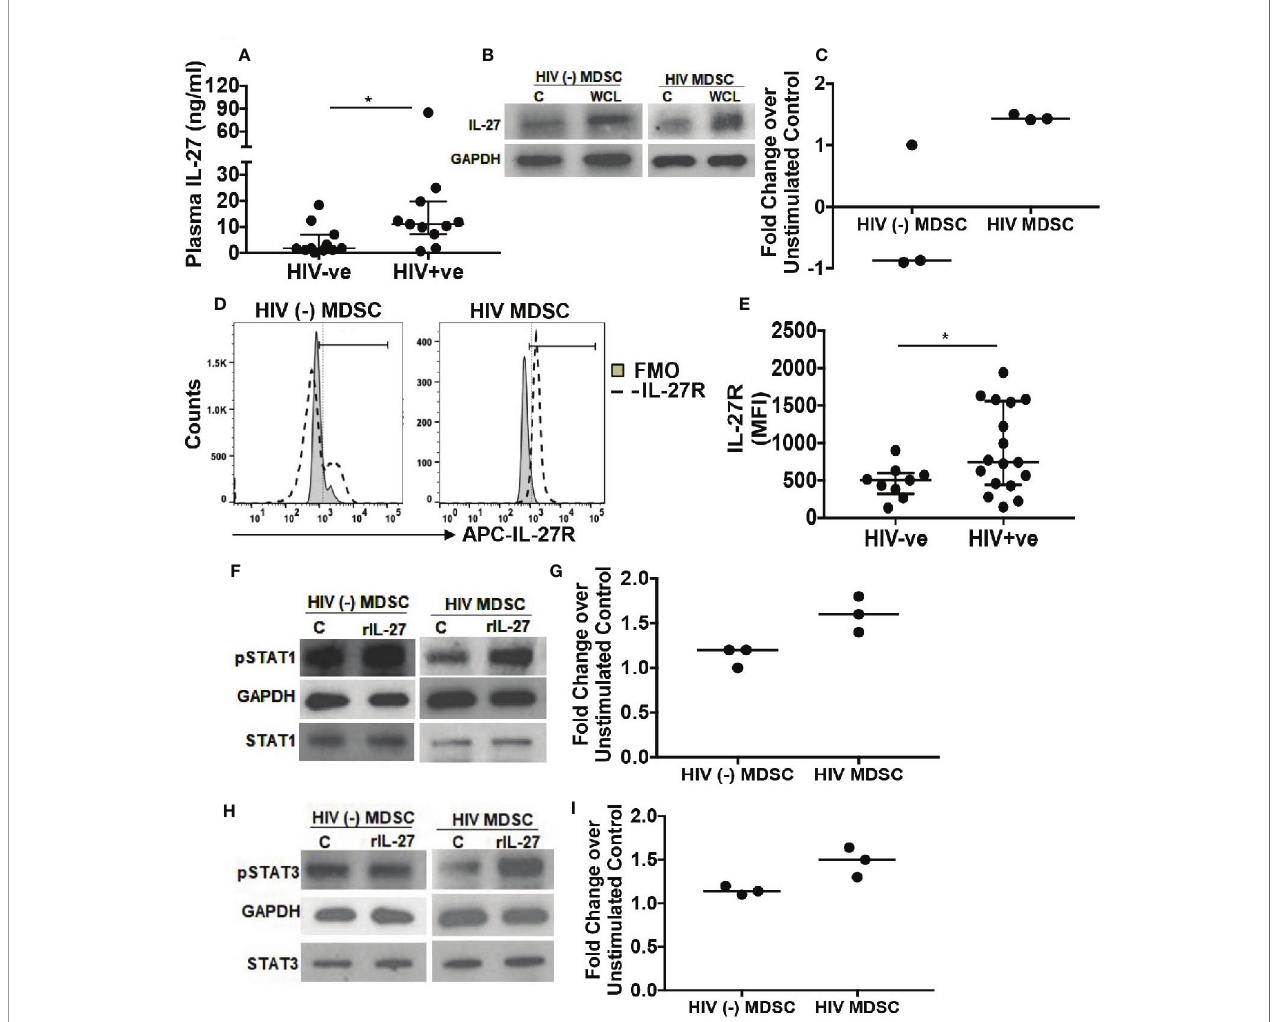
FIGURE 3 | Increased expression of IL-27 and IL-27R by HIV MDSC. To determine the role of IL-27, (A) IL-27 was quantitated in the plasma of HIV (-) and HIV (+) individuals with virologic suppression by ELISA. (B, C) HIV (-) MDSC and HIV MDSC were isolated and cultured without or with M tuberculosis WCL. Total cellular lysates were immunoblotted using anti-GAPDH and – IL-27A antibodies to determine the expression of IL-27p28. Representative Immunoblot of one HIV (-) MDSC and HIV MDSC donor is shown; vertical line is median (B) . (D, E) MDSC were isolated and surface stained with anti-IL-27 receptor (IL-27R) antibody. The expression of IL-27R was determined by fl ow cytometry and Mean Fluorescence Intensity (MFI) calculated. Representative fl ow cytometry plot is shown (D) . (F – I) To determine functional response of IL-27R, MDSC were isolated and stimulated with recombinant IL-27 (rIL-27) for 30-minutes. Total cellular lysates of unstimulated and rIL-27 stimulated cells were immunoblotted using anti-GAPDH, -total STAT1, -total STAT3, -p (Y701) STAT1 and – p (Y705) STAT3 antibody. Fold change was calculated as p -STAT1 or – STAT3 expression in rIL-27 stimulated cells/as p -STAT1 or – STAT3 expression in unstimulated cells. Representative Immunoblot of one HIV (-) MDSC and HIV MDSC donor is shown. For (A, E) , each dot representing an individual donor include observations from 25 th to 75 th percentile; the horizontal line represents the median value; for (C, G, I) each dot represents an individual donor; horizontal line represents the median. *p <